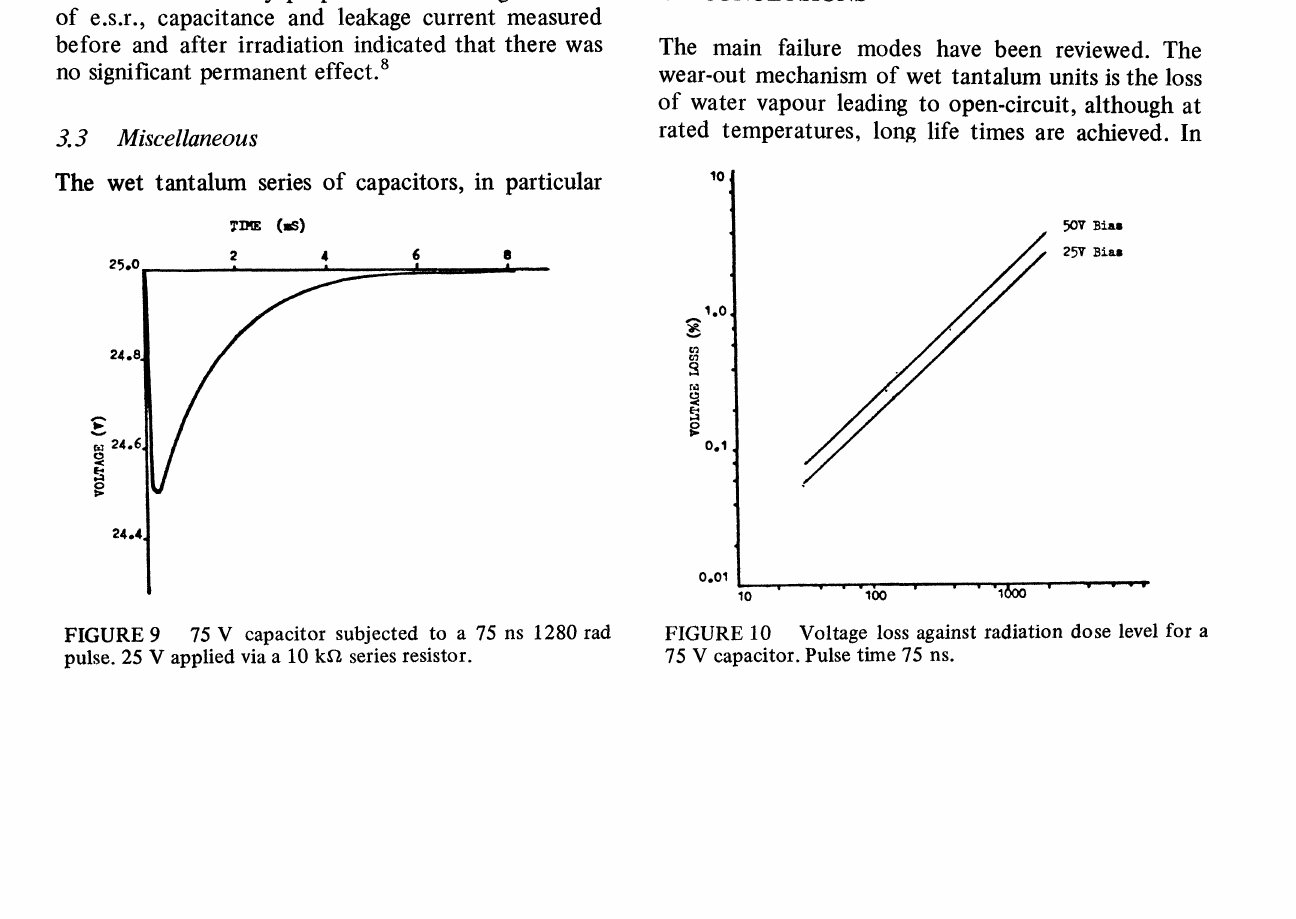
75 V capacitor subjected to a 75 ns 1280 rad pulse. 25 V applied via a 10 kS2 series resistor.